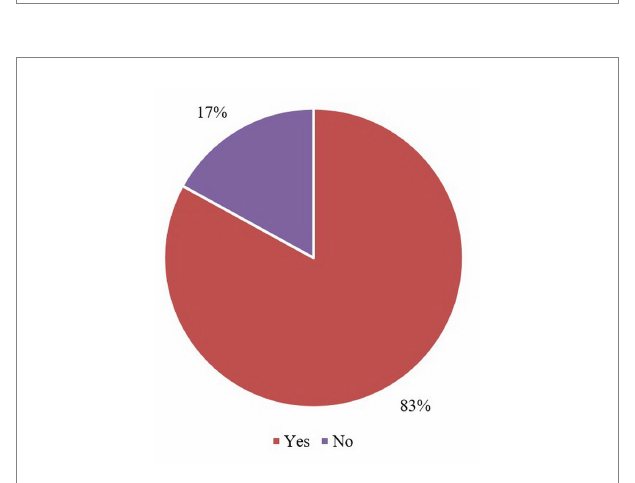
FIGURE 6 Answers to the question: do mobile applications and online educational courses influence learning, memory development, and knowledge sharing?. Source: compiled by the authors.